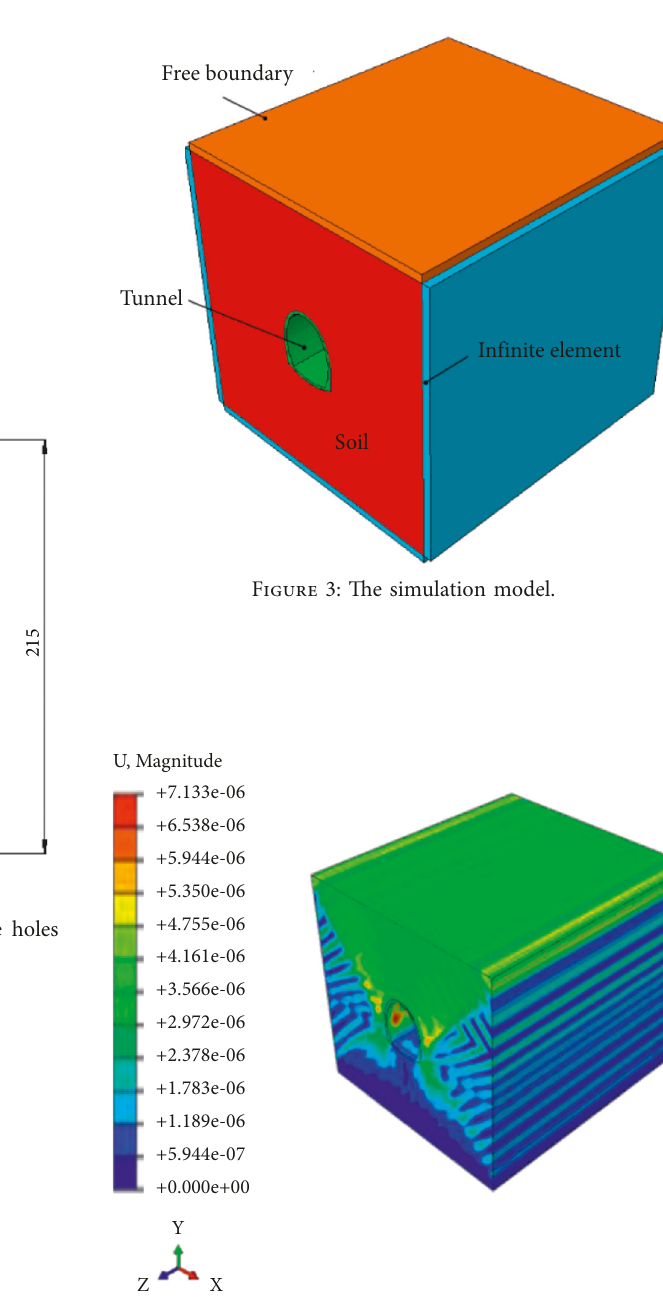
Figure 4: The results of in situ stress equilibrium